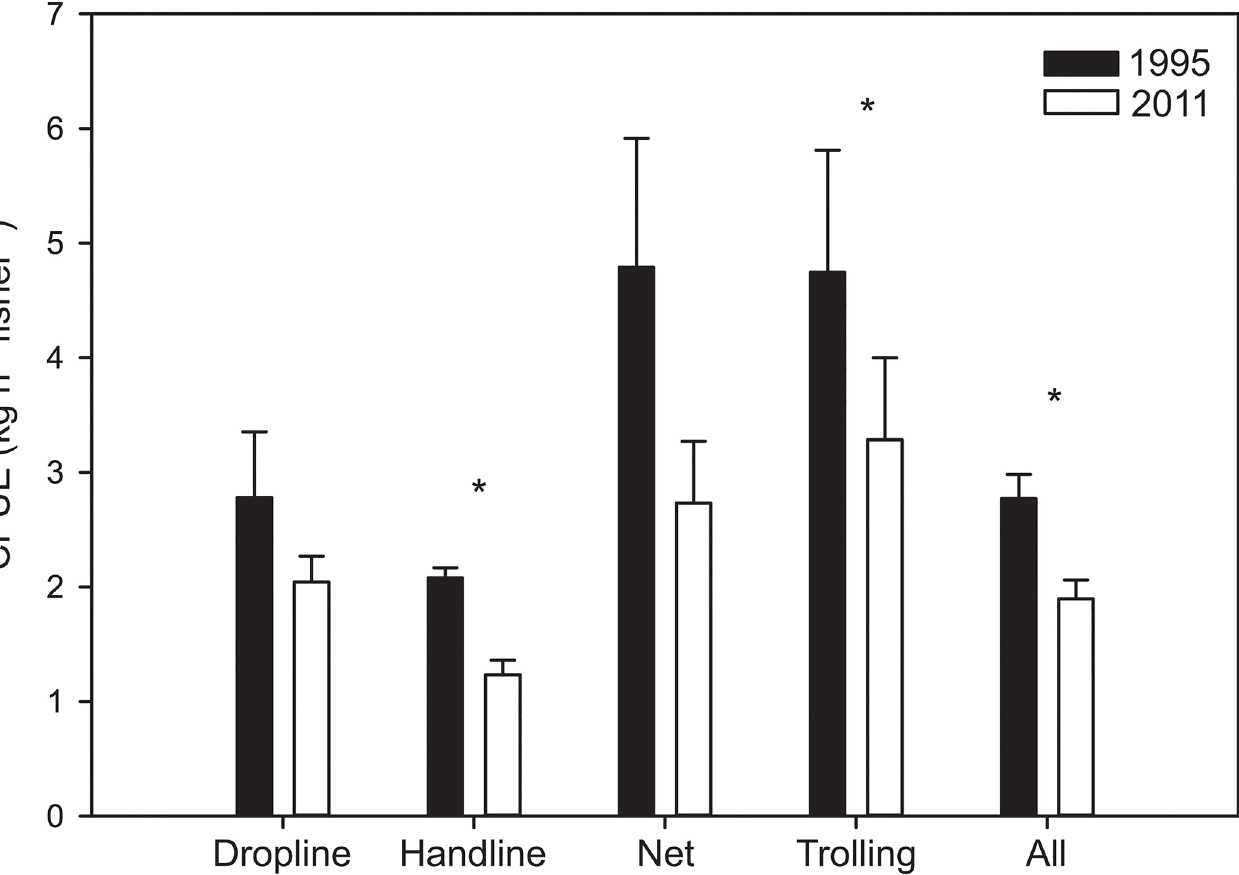
Fig 2. Catch per unit effort within the Roviana lagoon study area in 1995 and 2011. Graph indicates catch per unit effort (CPUE) within the study site for 1995 and 2011 by fishing method. Data significantly different between 1995 and 2011 using a Kruskal-Wallis test are shown ( *